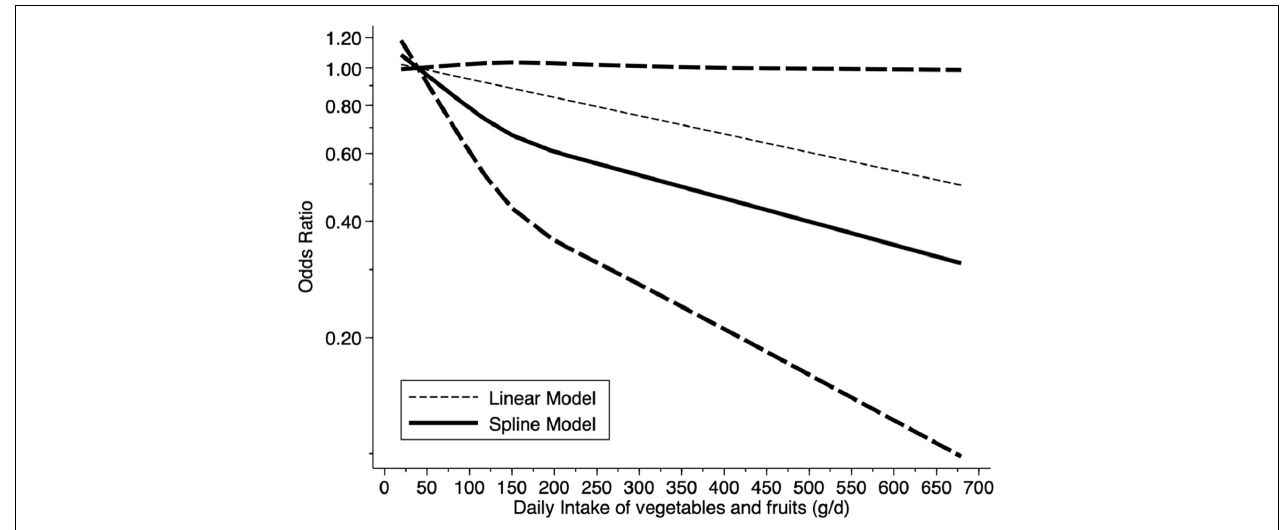
FIGURE 3 | Dose-response relationship between fruits and vegetables intake and prevalence of cognitive disorders.